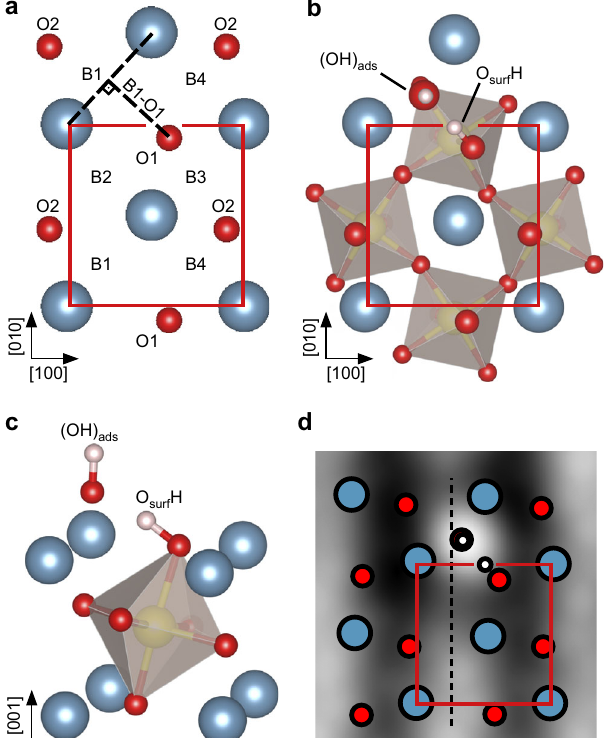
] Fig. 3 DFT model for water adsorption on cleaved Ca 3 Ru 2 O 7 . a Top view DFT model of the pristine surface (Ca — blue , O — red , H — white , Ru — yellow ). The unit cell is marked by the rectangle . The distances from the bridge sites B1 to B4 to the surface oxygen atoms O1 and O2 differ because of the tilted RuO 6 octahedra and are listed in Table 1. The distance B1-O1 is shown as an example, other distances are constructed analogously. b Top view and c side view of the DFT model of the most preferred con fi guration B1O1 for one dissociated water monomer with E ads_B1O1 = 1.64 eV. The fi rst subsurface layer of RuO 6 octahedra is shown. Water dissociates, forming an (OH) ads group adsorbed on Ca-Ca bridge site B1 with a H transferred to the neighboring surface oxygen atom, O1. The tilt angle of the hydroxylated RuO 6 octahedron increases from 12.9° to 16.3°, when compared to the pristine surface. The energetically equivalent con fi guration B2O2 is not shown. d According to Tersoff-Hamann simulations, STM shows the (OH) ads as a bright feature. When compared to the Ca-Ca bridge centre ( dashed line ), the (OH) ads sits slightly closer to the O surf H (in [100] direction)